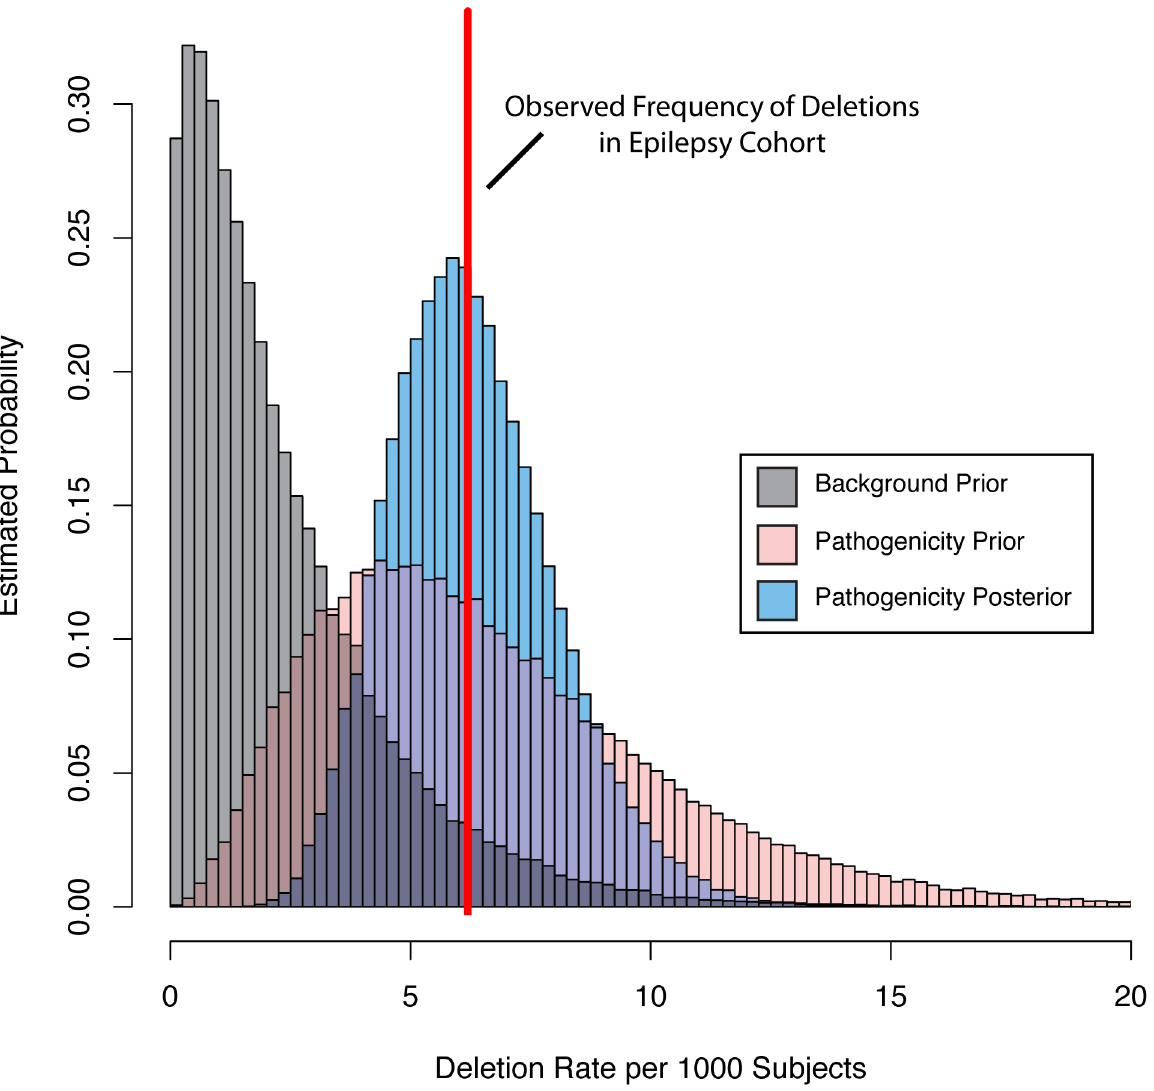
Figure 4. Bayesian integration of pathogenicity scores and mutation frequency for the KCTD13 gene. We parameterized a prior gamma distribution that models the baseline deletion frequency by setting the mean equal to the observed deletion rate in a background population referred for non-neurologic indications (grey distribution). We then varied the mean of a second gamma distribution based on the pathogenicity score (pink distribution). Next, we computed the probability of the observed rate (red line) of deletions among our subjects with epilepsy under the background and pathogenicity-informed models to arrive at the Bayes factor. Finally, we determined the posterior rate distribution (blue distribution), taking into account gene knowledge from the pathogenicity score, background deletion frequency from the non-neurologic cohort, as well as the observed rate among subjects with epilepsy. lists the frequencies, Bayes factors and posterior rate distribution parameters for each RefSeq gene.